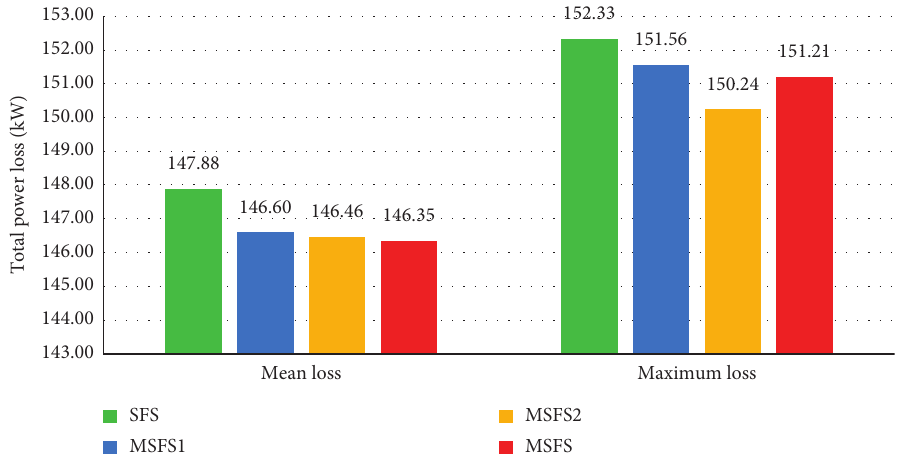
Figure 15: Mean and maximum power loss of 50 trial runs obtained by SFS methods for case 2 of the 69-bus system.